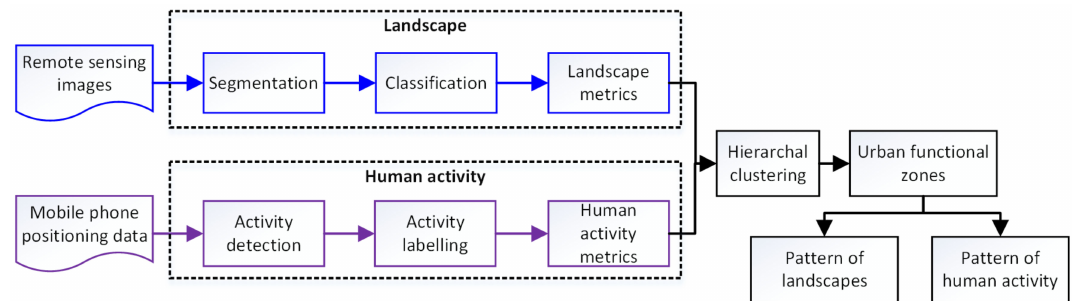
Figure 4. The workflow of the presented